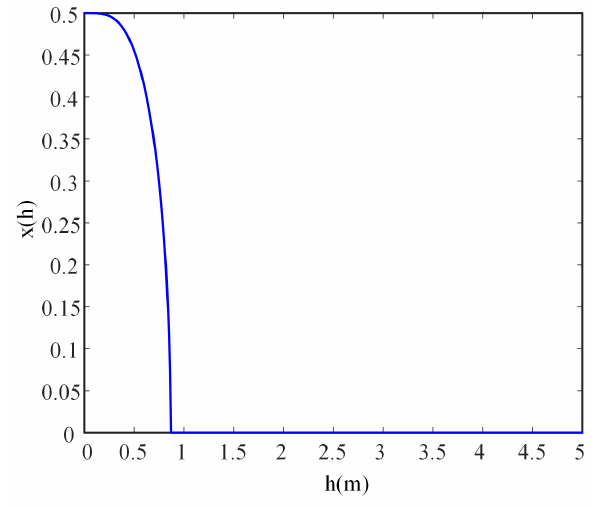
Figure 3. The relationship between the UAV’s abscissa and height.